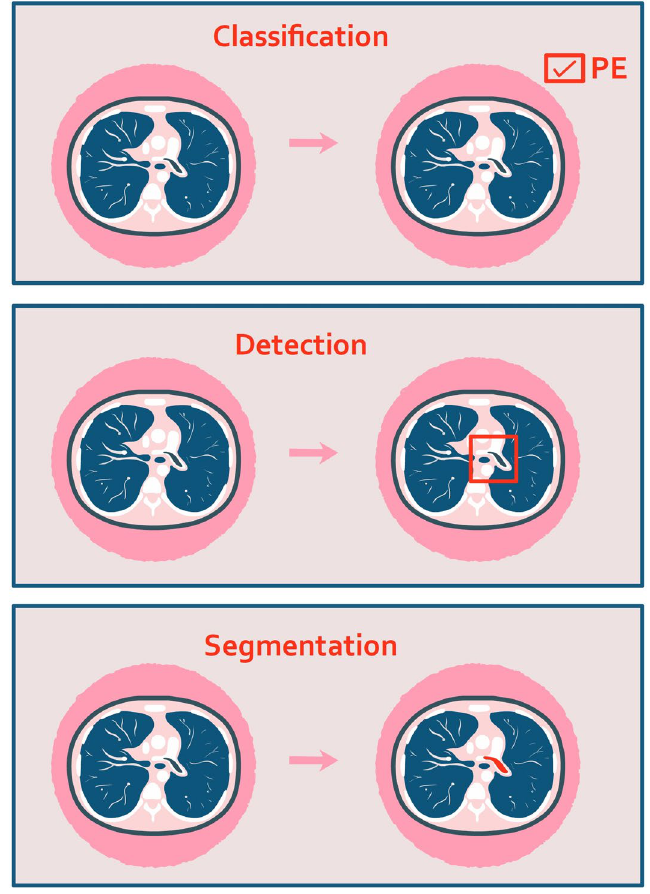
Figure 4. Main computer vision tasks: classification, detection, and